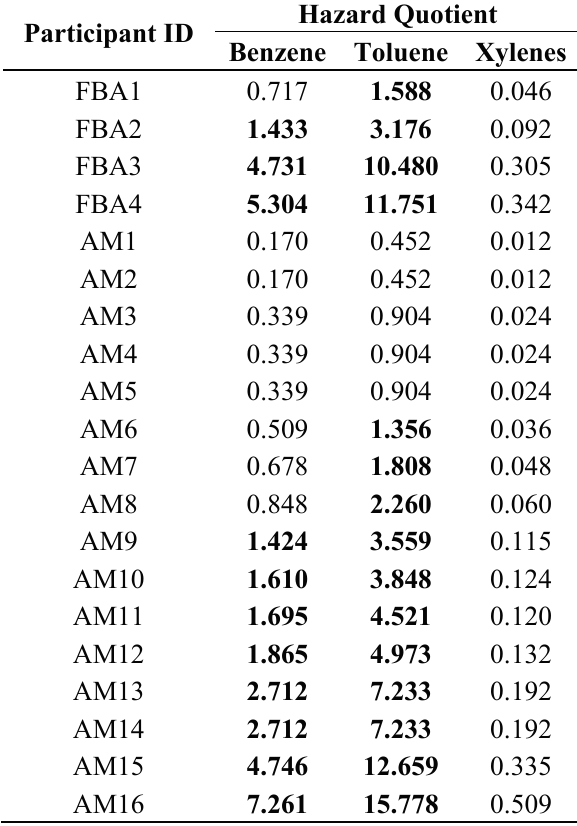
Table 5. The hazard quotient (HQ) for benzene, toluene and xylenes; indicating the